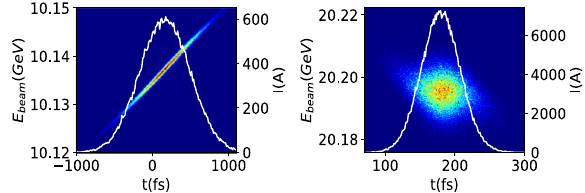
FIG. 3. Beam distribution in longitudinal phase space after passing through linac 1 (left) and linac 2 (right) for 20 GeV FEL operation, obtained by tracking with ELEGANT [37], including the linac wakefields from Ref. [29], and the shielded CSR impedance from CSRZ [24]. The white line represents the current profile. The final FWHM bunch length is 63 fs, or 19 μ m, and the fitted rms bunch length σ z ¼ 8 . 5 μ m.